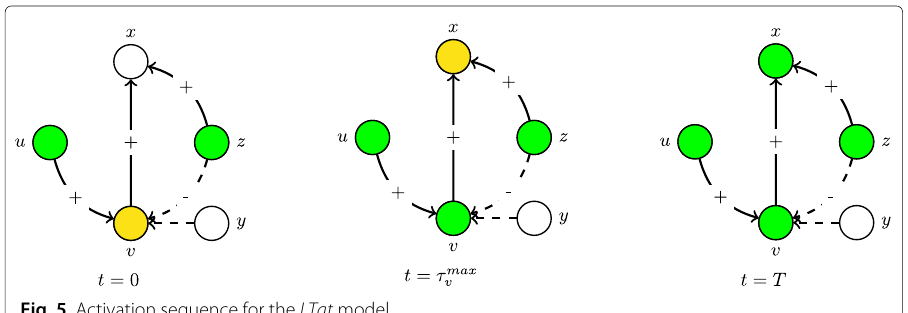
Fig. 5 Activation sequence for the LTqt